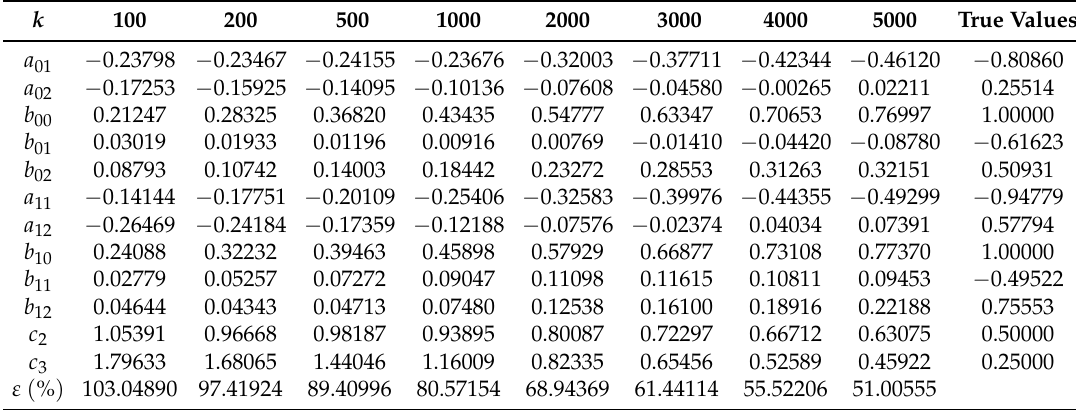
Table 1. The auxiliary model-based multi-innovation stochastic gradient (AM-MISG) parameter estimates and errors ( p = 1).